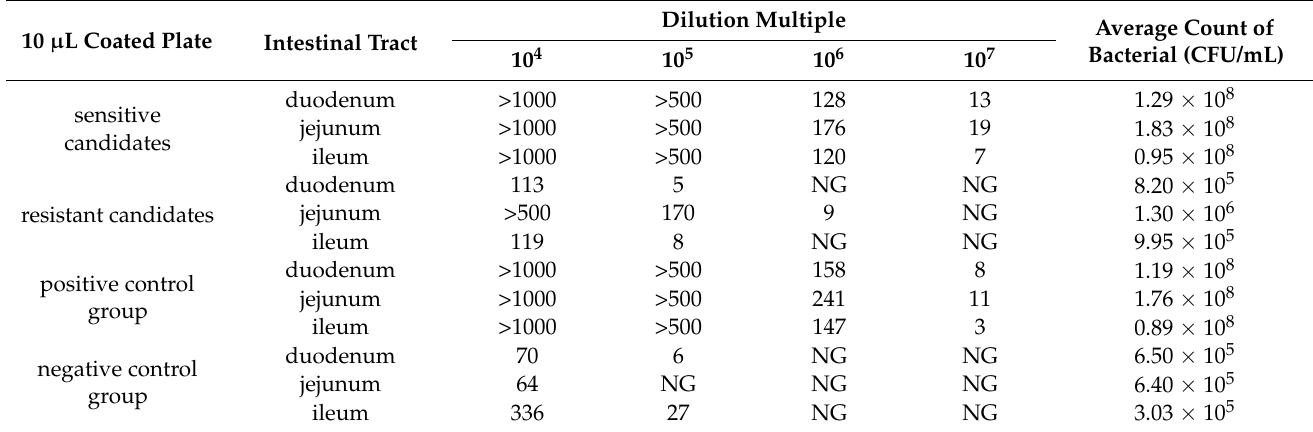
Table 4. Comparison of bacterial numbers in lambs in different groups.